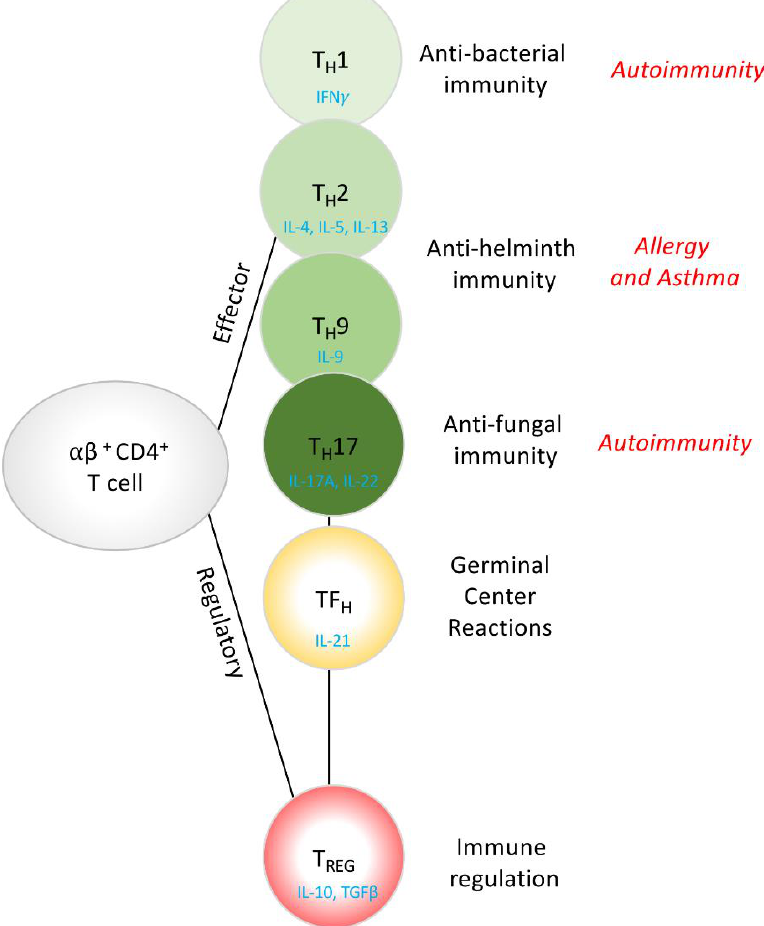
Figure 1. Naïve CD4 + T cells di ff erentiate, in the thymus or periphery, into a variety of e ff ector or regulatory phenotypes. The current model of T cell di ff erentiation can be appreciated through their function, with IFN γ -secreting T H 1 cells providing protection from intracellular pathogens, including bacteria, viruses, and parasitic protozoa. IL-4, IL-5 and IL-13-secreting T H 2 cells, and IL-9-secreting T H 9 cells providing protection from extracellular pathogens including parasitic helminths, IL-17A and IL-22-secreting T H 17 cells providing protection from extracellular pathogens including fungal infections. IL-21-secreting TF H cells help orchestrate the germinal center for B cell activation and antibody production and finally, IL-10 and TGF β -secreting T REG cells providing regulation of adaptive and innate immune responses via suppressive mechanisms. Dysregulated T cell responses can give rise to Autoimmunity, Allergy and